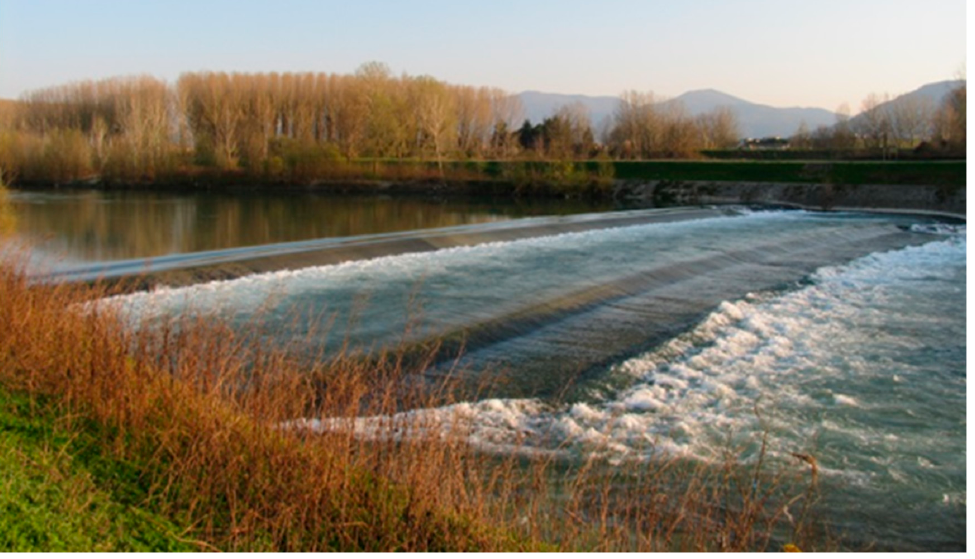
Figure 2. The Sant’Alessio weir on the Serchio River.